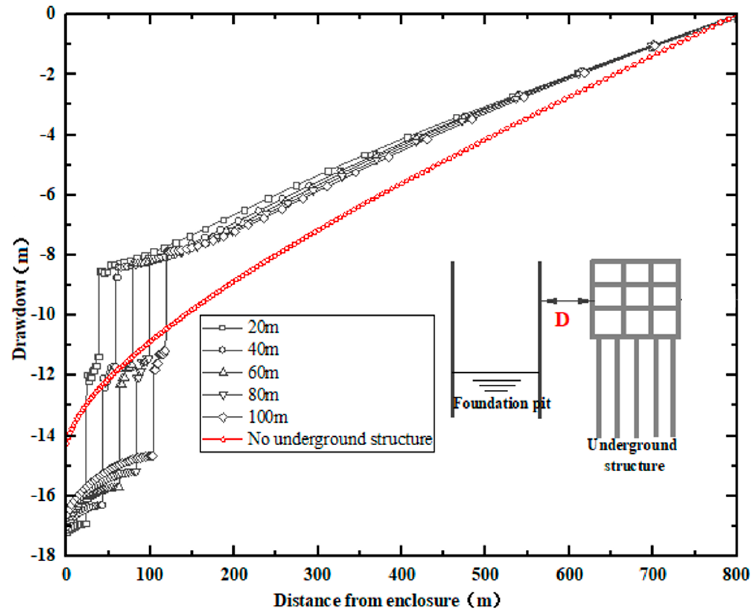
Figure 4. Distribution of groundwater drawdown under different D .